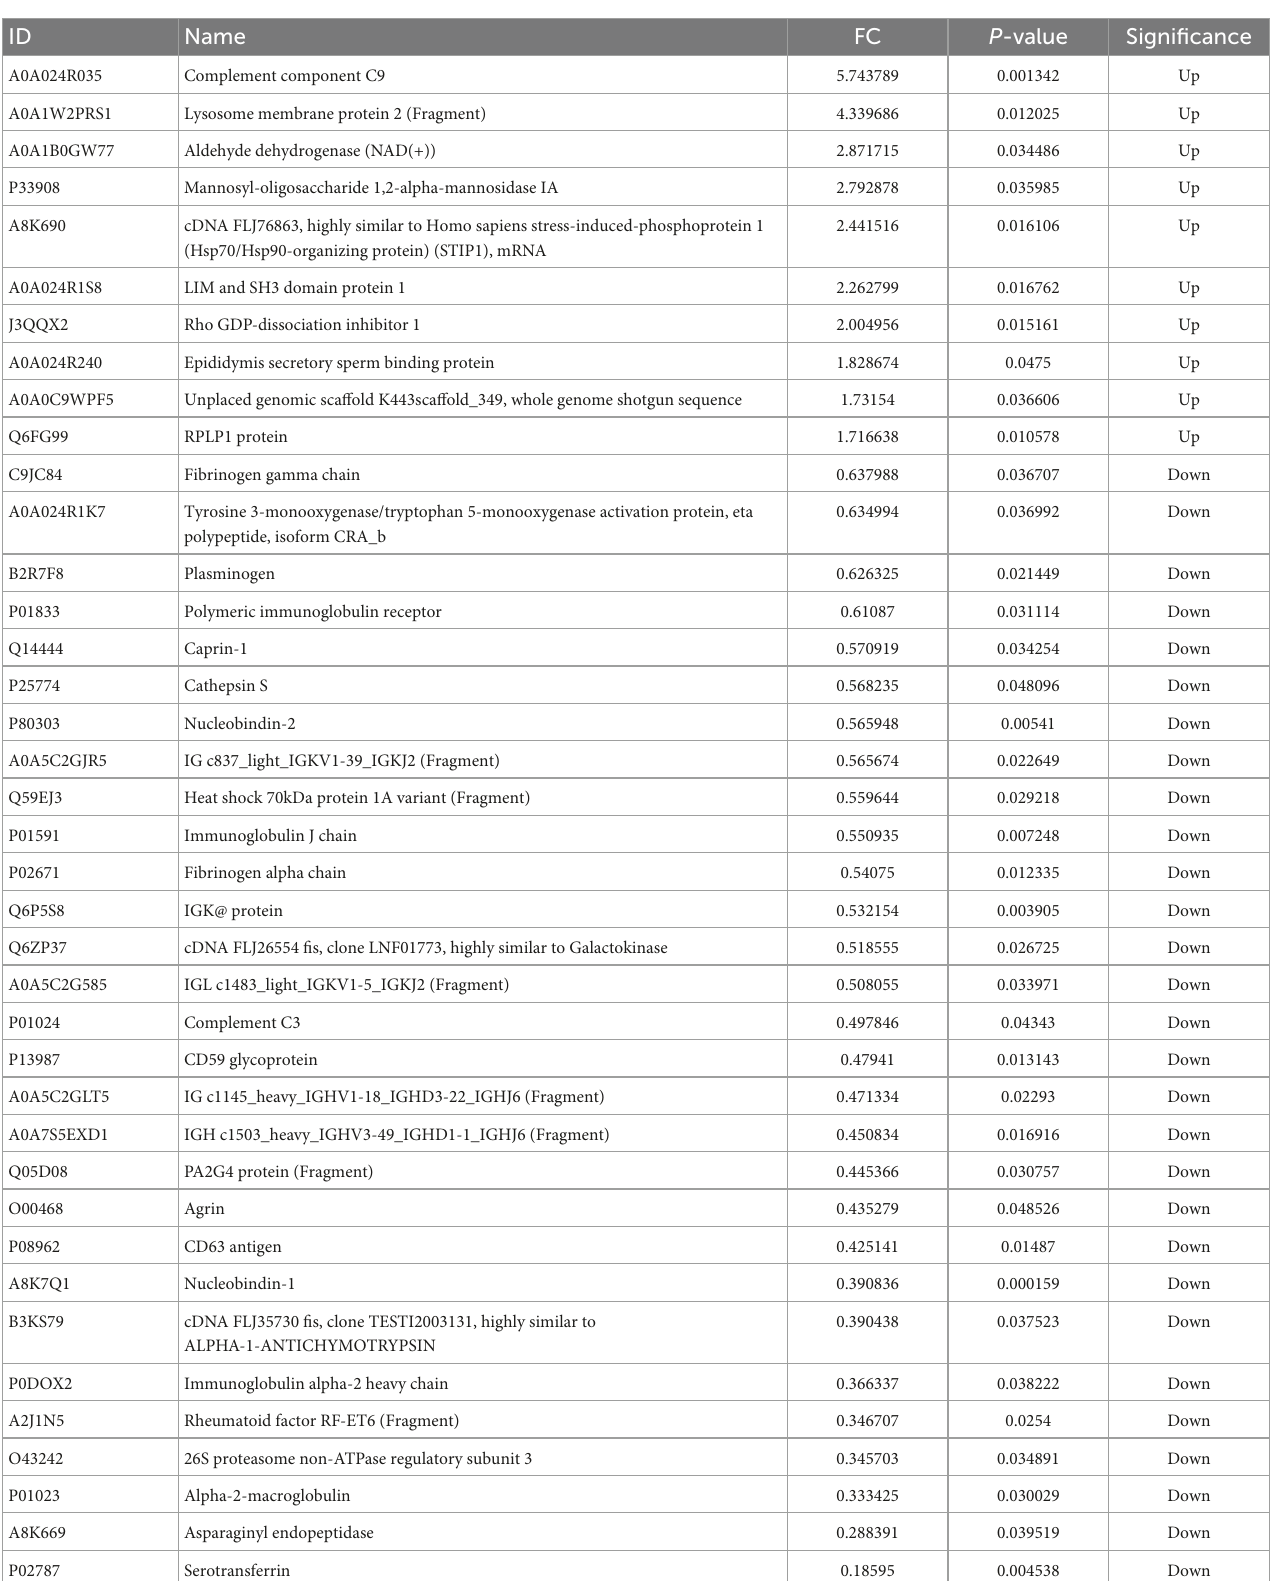
TABLE 1 Differentially expressed proteins in human milk casein (Korean VS.